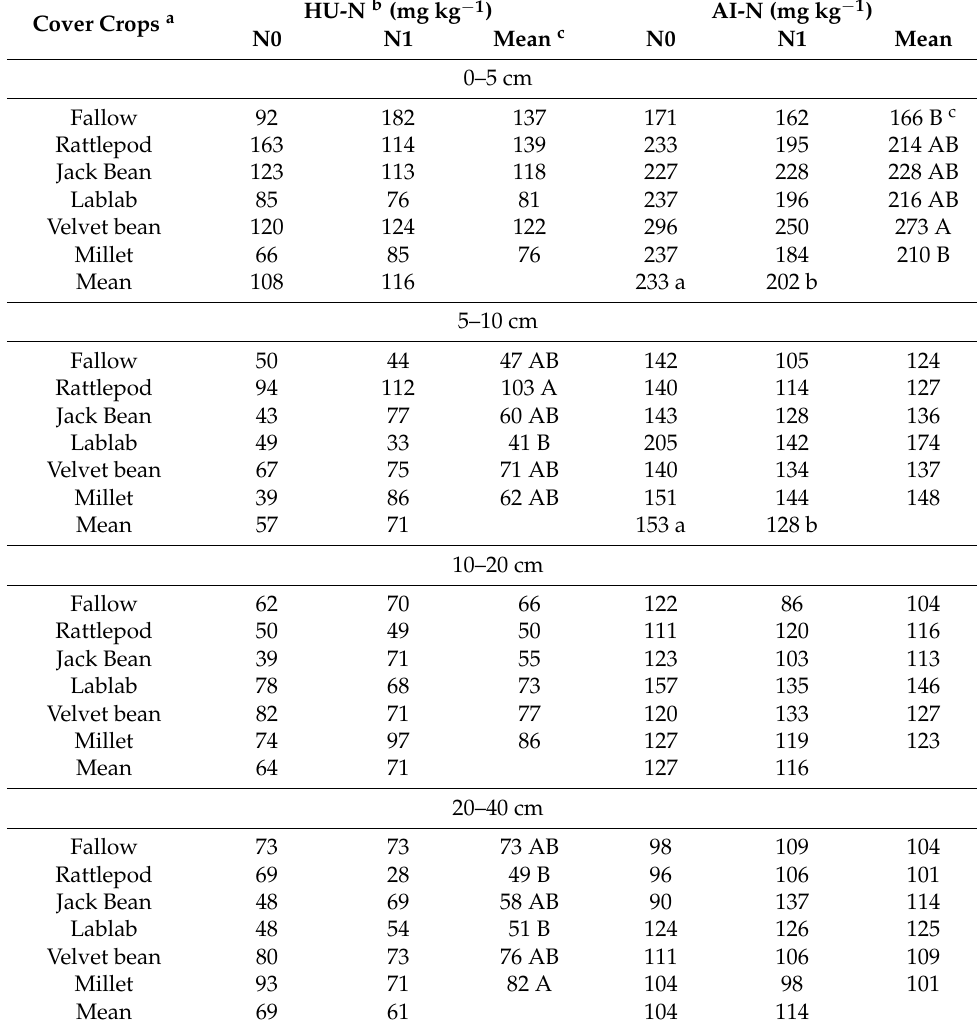
Table 6. Concentrations of hydrolyzable unidentified and acid-insoluble soil nitrogen fractions from soil samples collected from 0–5, 5–10, 10–20, and 20–40 cm depths as a function of cover crops grown before maize and nitrogen fertilizer